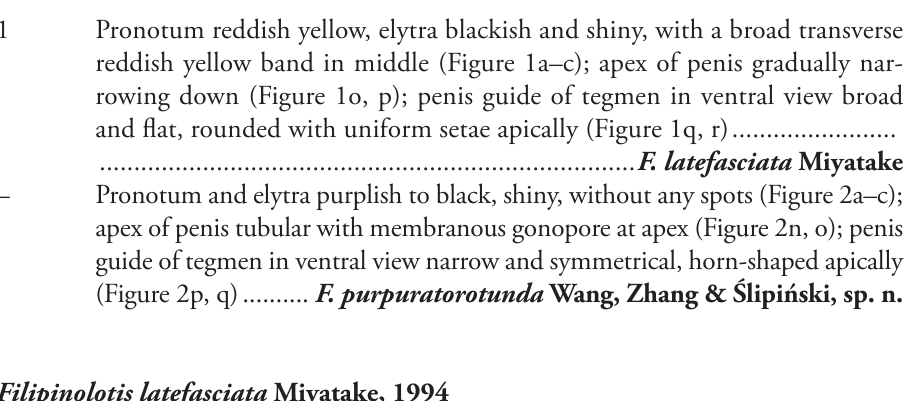
Diagnosis. This species can be recognized by the following combination of characters: pronotum reddish yellow, elytra blackish shiny with a broad transverse reddish yellow band in the middle (Figure 1a–c); penis guide of tegmen in ventral view broad and flat, with a rounded apex, parameres narrow and almost straight with dense setae at apices (Figure 1q–r); penis uniformly tubular, curved, gradually narrowing to apex (Figure